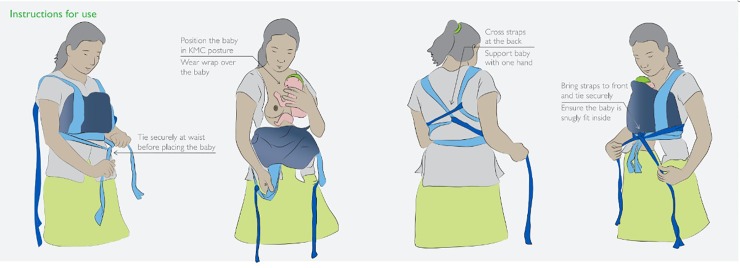
Instructions for CarePlus Wrap use.